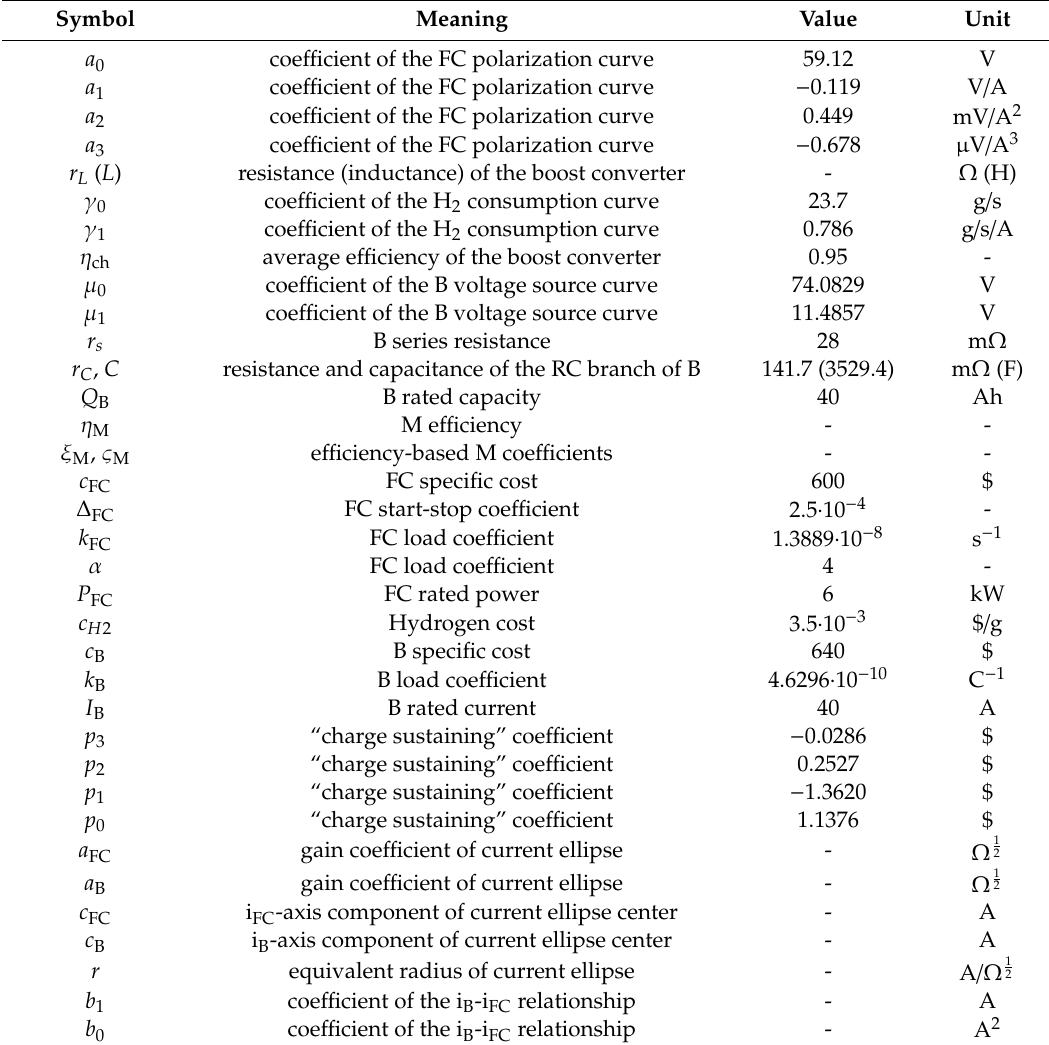
Table A2. List of parameters